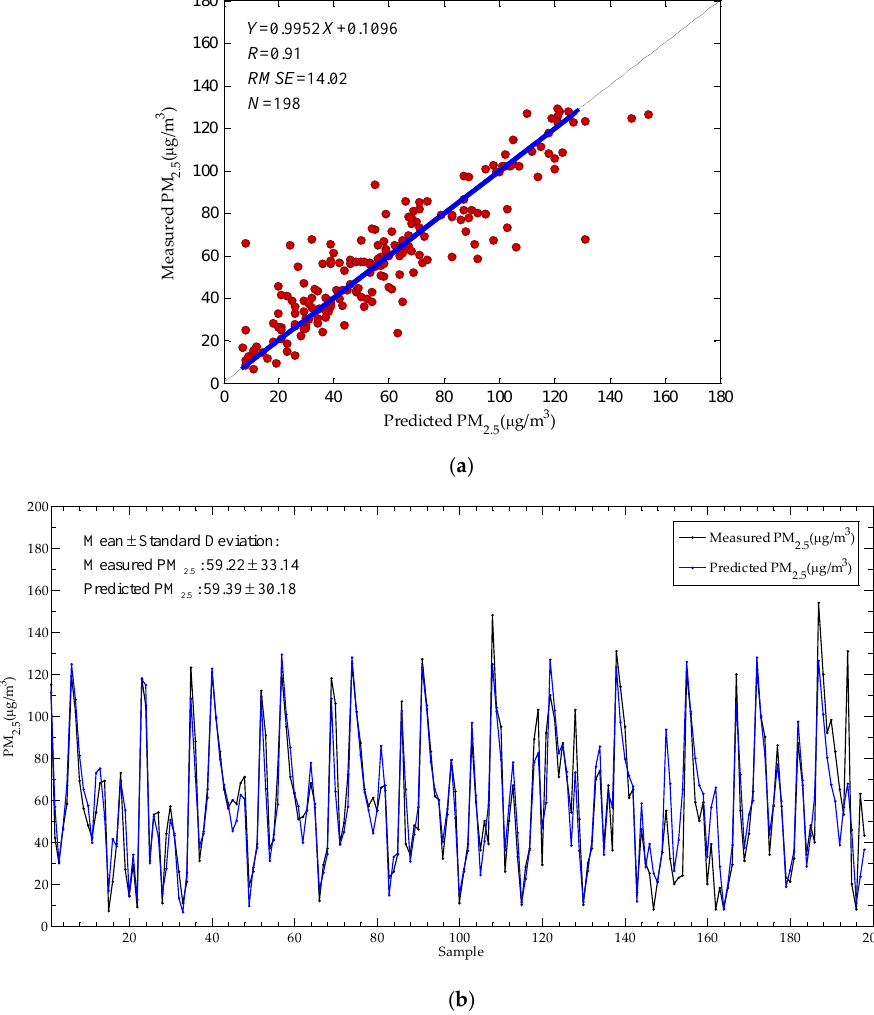
Figure 5. Comparison of PM 2.5 mass concentration values inverted by the BP neural network model and TEOM1405F monitoring values. and TEOM1405F monitoring